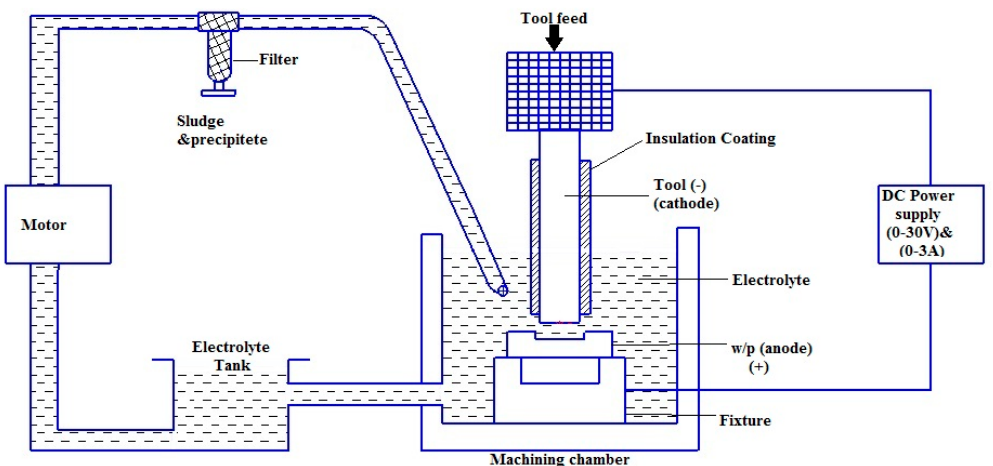
Figure 1. Schematic representation of the electro-chemical micro machining (ECMM) process.